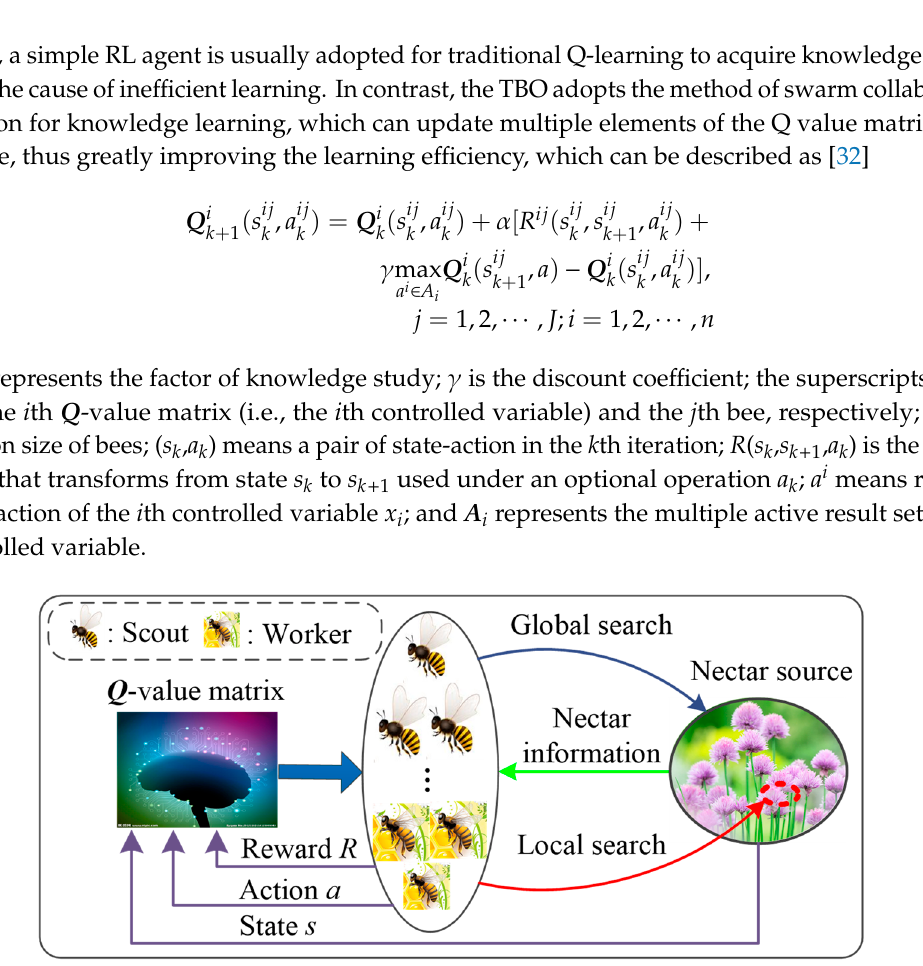
Figure 2. The principle of knowledge learning of the TBO inspired by the nectar gathering of bees.